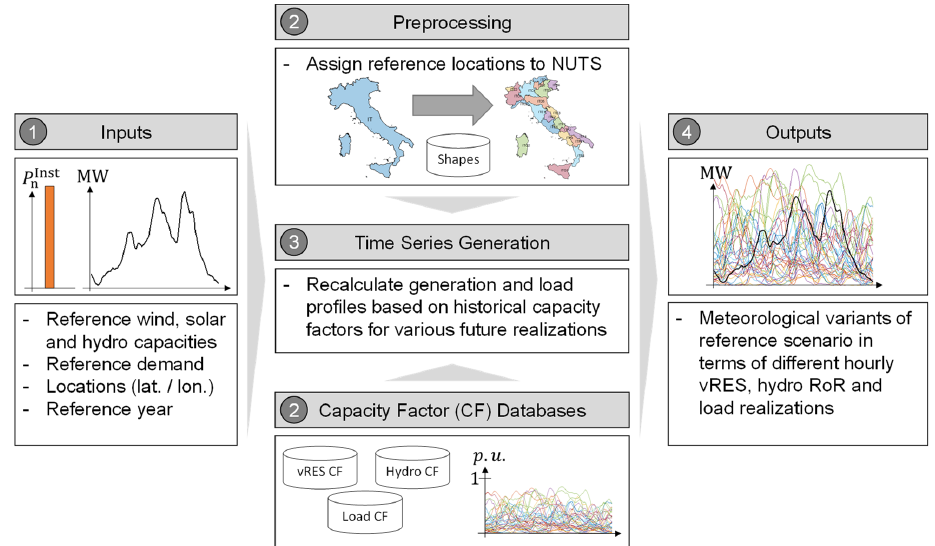
Figure 13. Schematic overview of the process generating meteorological variants for the Monte Carlo approach.